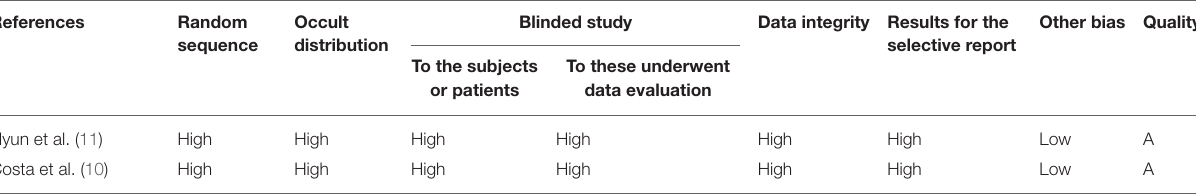
TABLE 2 | Methodology evaluation for the eligible